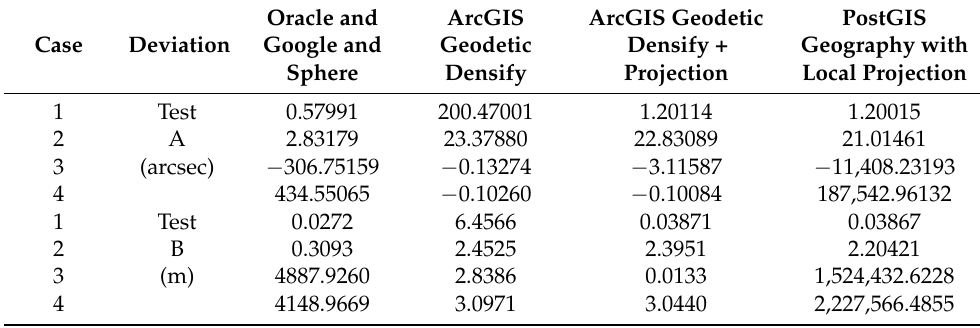
Table 2. Azimuth and distance deviation (estimation).